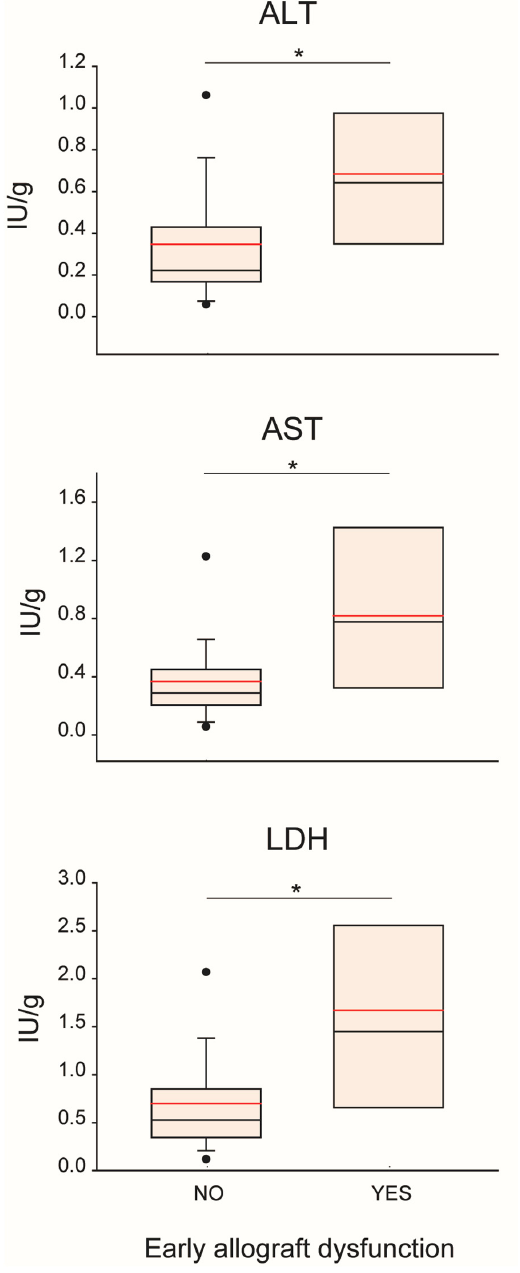
Figure 3. Effluent cytolysis enzymes according to Early Graft Function (EAD) occurrence. Patients that developed EAD after LT showed increased effluent concentration of biomarkers of hepatocellular lysis. Boxes denote median 5th–95th percentiles; red lines highlight the mean of each study group, while black points denote outliers. Statistical significance was investigated using Wilcoxon non-parametric test. p value: * <0.05. ALT, alanino transferase; AST, aspartate amino transferase; LDH, lactate dehydrogenase.